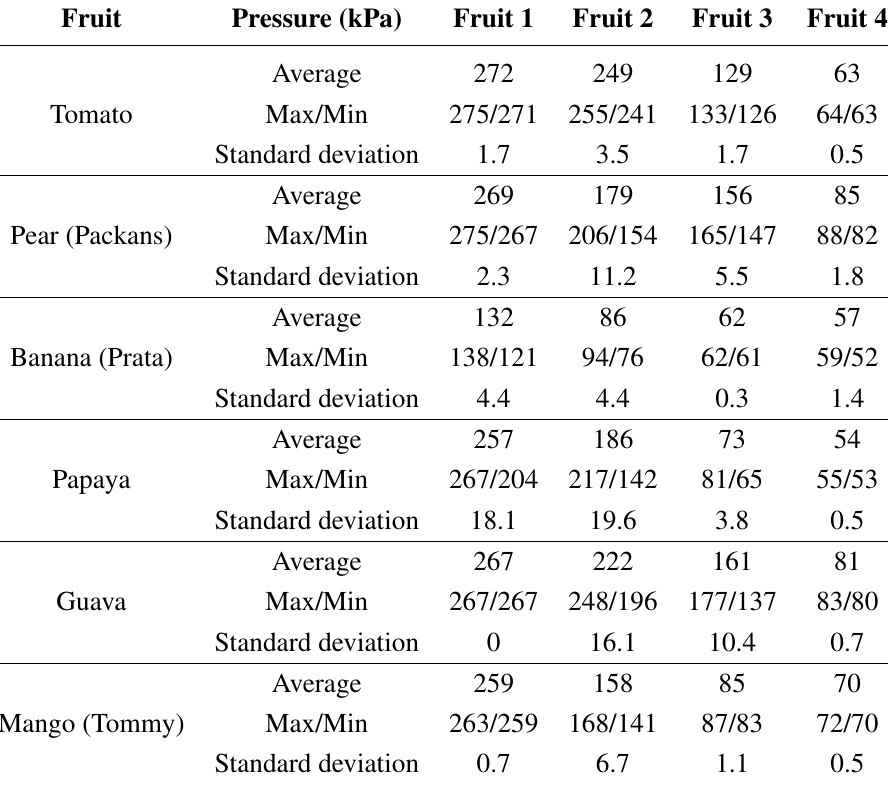
Table 2. Turgor pressures in Kilo-Pascal (kPa) for the measured fruits. The averages are computed based on 30 measurements.